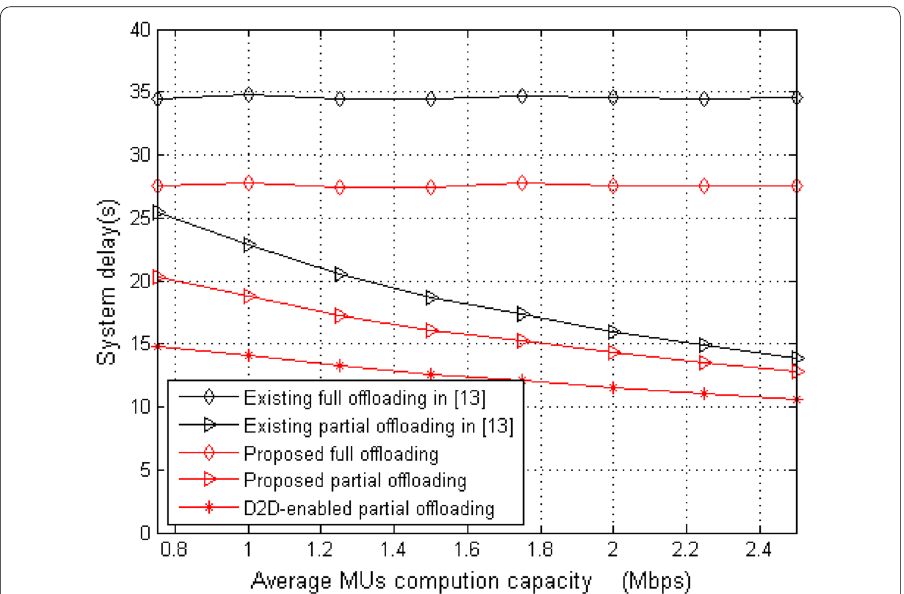
Fig. 6 The system delay versus the average computation capacity of